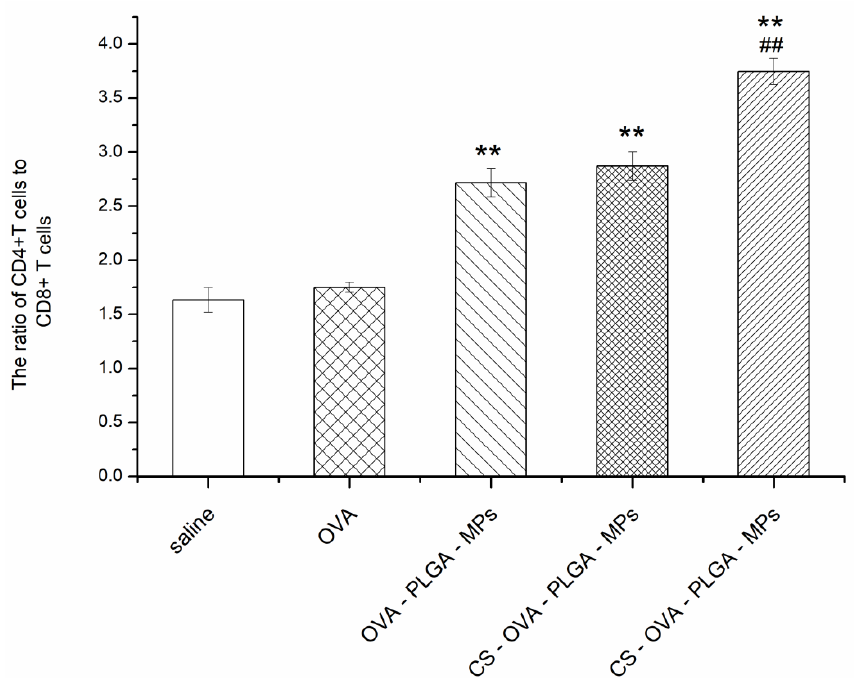
Figure 8. Effects of MAN-CS-OVA-PLGA-MPs on the ratio of CD3 + CD4 + T cells to CD3 + CD8 + T cells in spleen cells of mice 28 days following the first immunization. Blood samples were collected and the ratio of CD4 + /CD8 + was determined by FACS. Results are presented as the mean ±